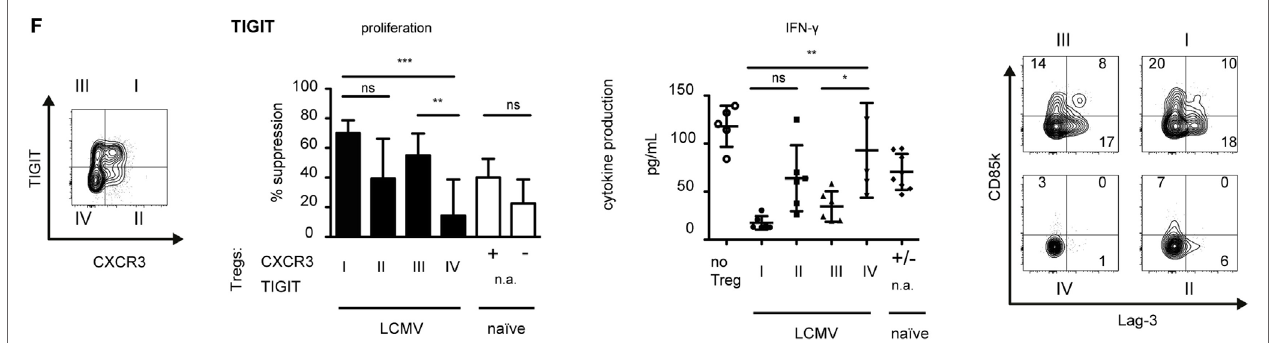
FigUre 5 | CXCR3 + Treg cells are superior suppressors of Th1 responses. Foxp3 -GFP reporter mice were infected with LCMV (days 10–14) or left naïve and CD4 + Foxp3 + Treg cells expressing the indicated markers were sorted from pooled spleen and LNs. (a,B) CD4 + Foxp3 + CXCR3 + (solid line) or CD4 + Foxp3 + CXCR3 − (gray line) Treg cells from LCMV-infected mice or CD4 + Foxp3 + (dotted line) Treg cells from naïve mice were titrated onto (a) CD4 + Foxp3 − CD62L high or (B) CD4 + Foxp3 − CD44 high effector T cells (Teff) from LCMV-infected mice (days 10–14) stimulated with anti-CD3 in the presence of irradiated antigen presenting cells for 72 h. 3 H-thymidine was added for the last 18–22 h to measure proliferation (left) (mean ± SD, technical replicates, n = 3, representative experiment of > 4 independent experiments). Cytokine levels in the supernatants were measured by cytometric bead array (right) (mean ± SD, technical replicates, n = 4, summary data from two independent experiments). (c–F) Suppression assays were performed as in (a,B) using total CD4 + Foxp3-GFP − effector T cells isolated from LCMV-infected mice in the presence of the indicated Treg subset (I–IV or naïve) at a 1:8 (D–F) or 1:4 (c) ratio. [ (c–F) , left] Suppression of proliferation (mean ± SD, technical replicates, CD85k and Lag-3 n = 3; Tim-3 and TIGIT n = 6, representative experiment of ≥ 3 independent experiments, one-way ANOVA with Tukey’s multiple comparison posttest) and cytokine secretion as assessed in supernatants (mean ± SD, technical replicates, CD85k and Lag-3 n = 3, Tim-3 and TIGIT n = 5–6, naïve (c,D) n = 3 (e) n = 4, (F) n = 7, representative experiment of ≥ 2 independent experiments, one-way ANOVA with Tukey’s multiple comparison post test) is shown (n.a., not applicable). [ (c–F) , right] Representative FACS Plots of indicated Treg subsets co-expressing multiple co-inhibitory